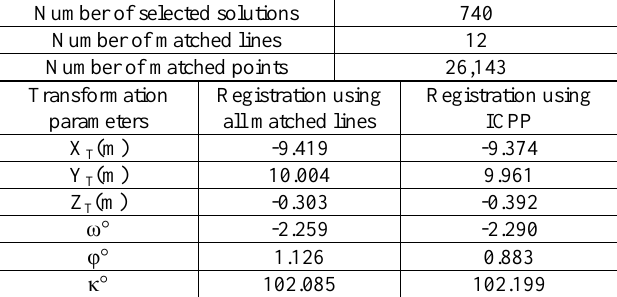
Table 2. Automatic registration results for scans 11 and 20